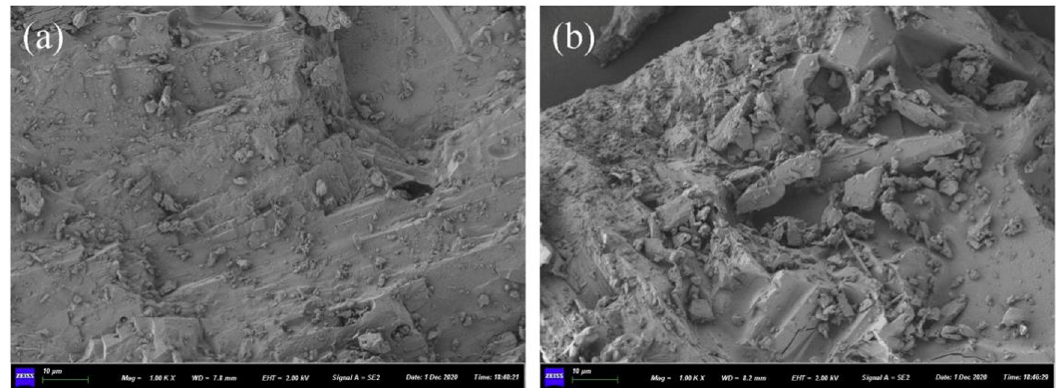
Figure 11: SEM images of SiO 2 system slag ( a ) and fl y ash system slag ( b )